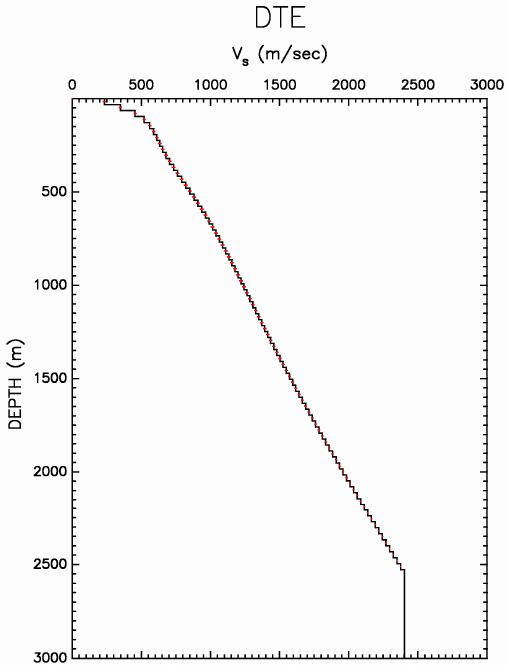
Figure 8. The S-wave velocity structures estimated using the surface-wave inversion technique (Herrmann [22]) at site DTE.